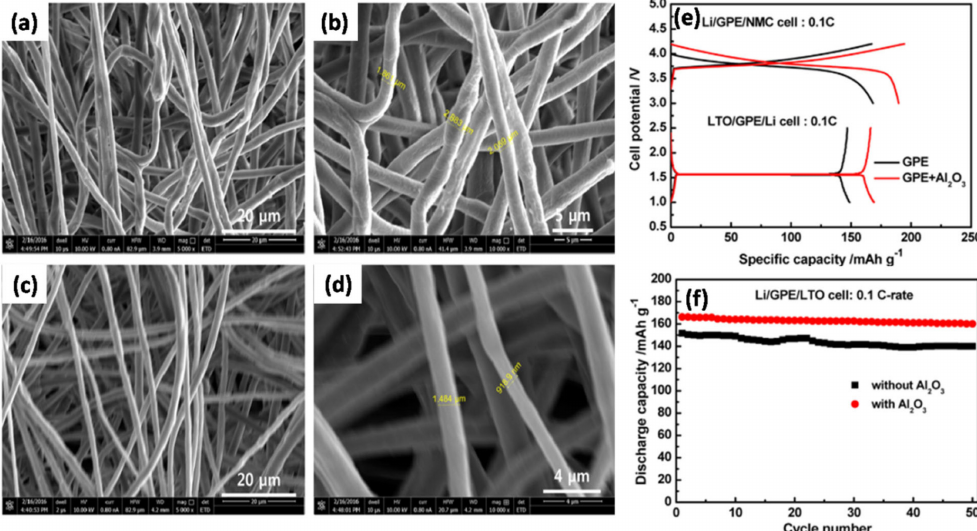
Figure 11. Morphology of ( a , b ) pristine GPE and ( c , d ) Al 2 O 3 -GPE membrane. ( e ) Initial charge–discharge curves of the Li 4 Ti 5 O 12 (LTO) and LiNi 1/3 Mn 1/3 Co 1/3 O 2 (NMC) half cells and ( f ) the cyclic performance of the GPE membrane. Reprinted with permission from Kim et al. [100]. Copyright 2017 Elsevier